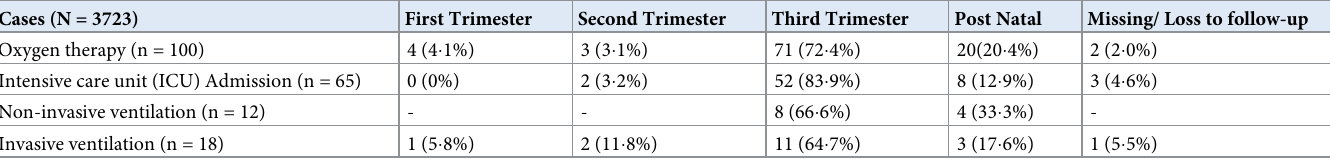
Table 5. Trimester wise distribution of COVID-19 cases requiring additional support.